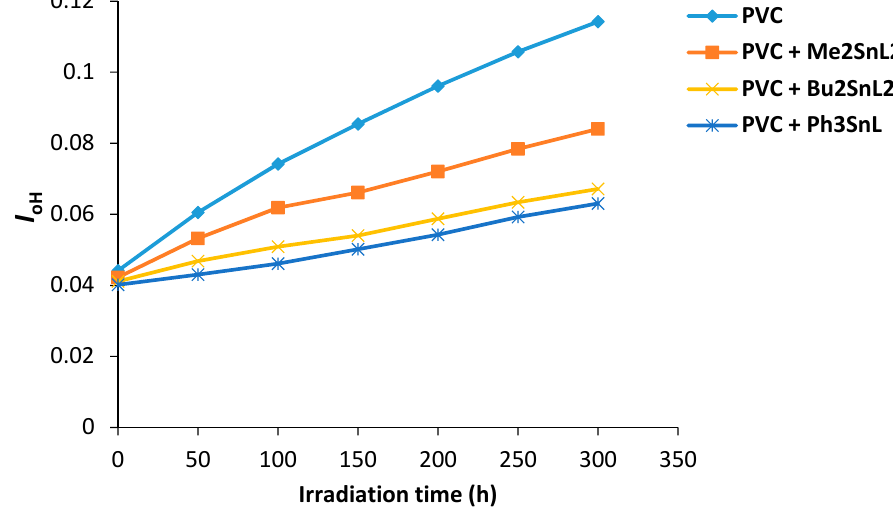
Figure 6. Changes in the I OH index for PVC films versus irradiation time.